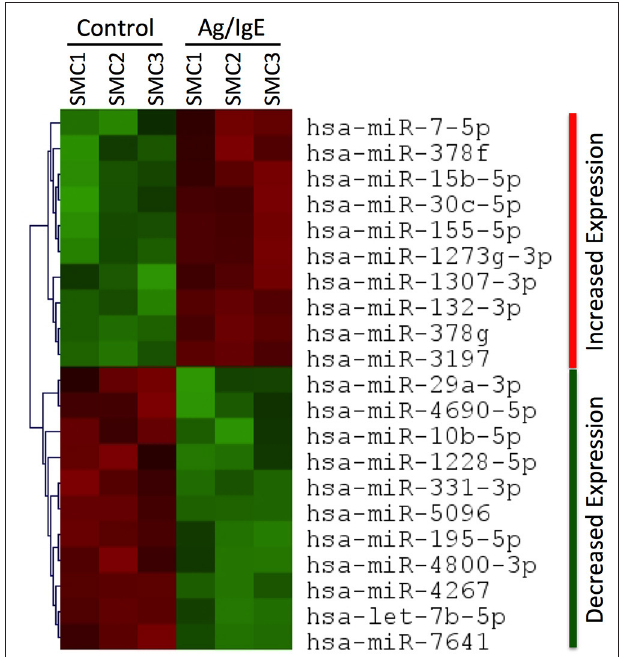
FIGURE 1 | miRNA profiling in human SMCs. Heat map showing significant ( p < 0.01) changes in miRNA expression in human SMCs following Fc ε RI crosslinking. RNA was extracted from SMCs that were sensitized with chimeric human anti-NP IgE (1 µ g/ml) and activated for 3h at 37 ◦ C with the multivalent antigen NP-HSA (1ng/ml). The heat map identifies 10 miRNAs that were significantly ( p < 0.01) upregulated (red) and 11 that were significantly downregulated (green) in Ag/IgE-activated SMCs ( n = 3 different cultures from different donors). All data can be found in the Supplementary Material .